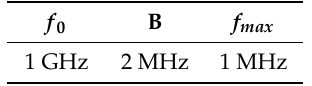
Table 1. Fixed simulations parameters.